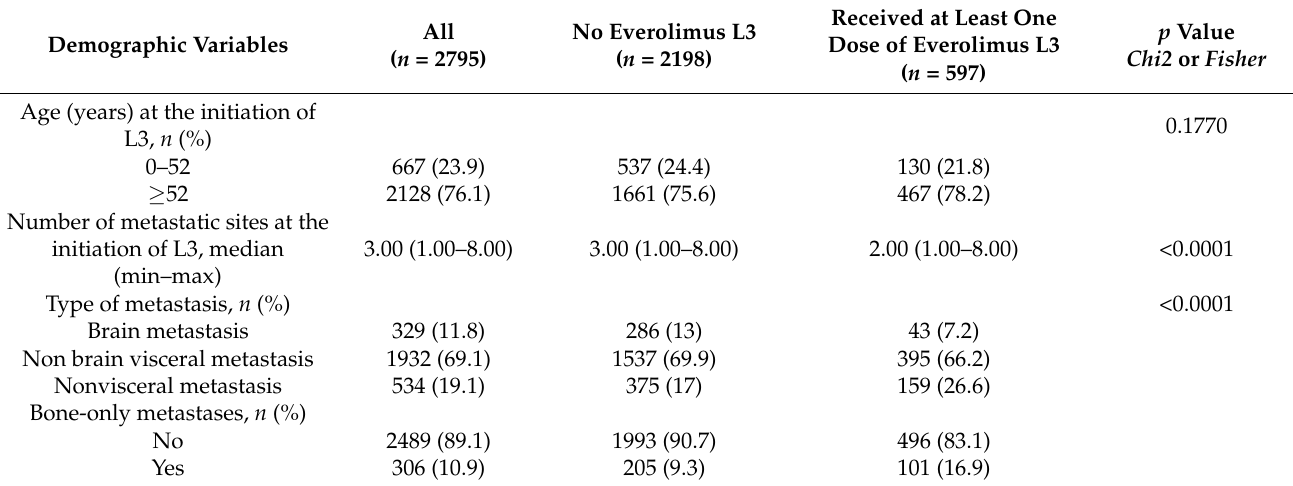
Table 4. Patient characteristics at the initiation of line 3 and